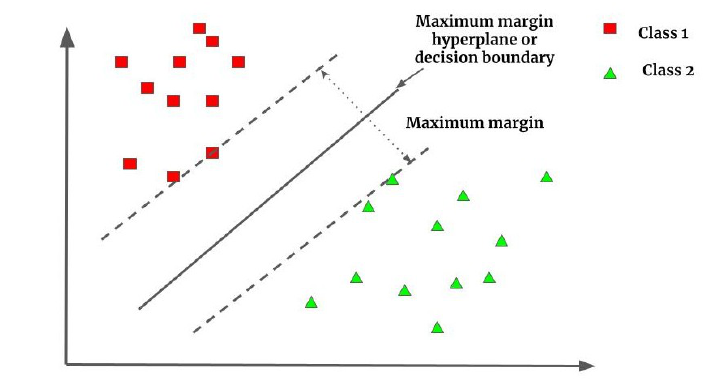
Figure 5. Working principle of an SVM classifier algorithm. The two classes are represented by green triangles and red squares. A decision boundary separating the two classes is defined and optimized by maximizing the distance between extreme vector